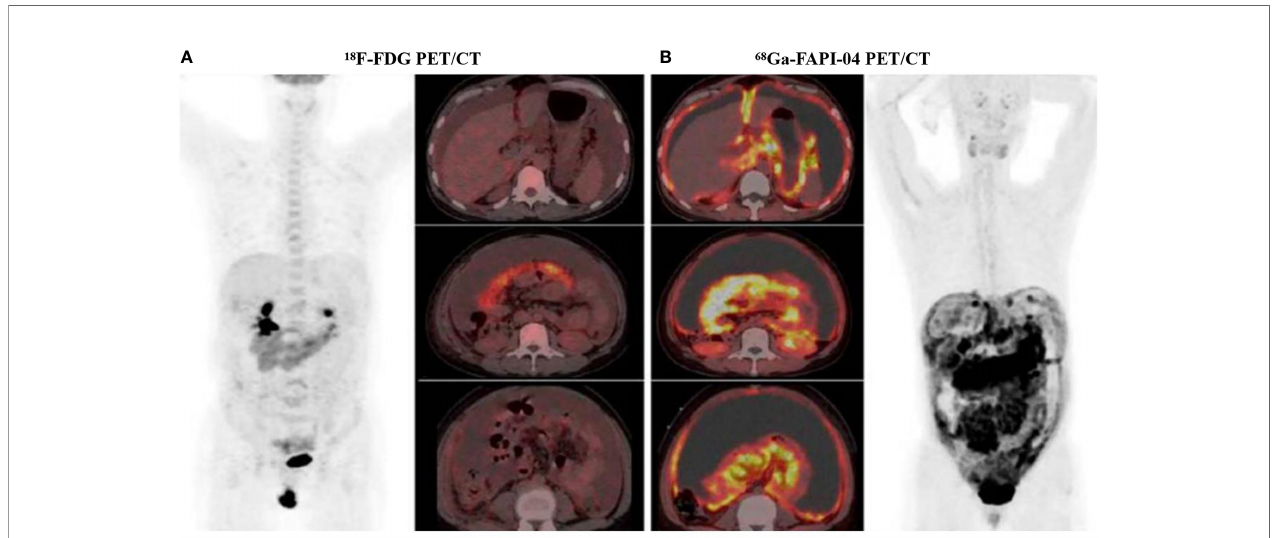
FIGURE 4 | A 47-year-old woman diagnosed with ovarian cancer, 18 F-FDG PET/CT showed the omental-cake-pattern of peritoneal carcinomatosis with low-to- moderate activity throughout the entire abdomen and pelvis (A) . However, there were more details in 68 Ga-FAPI-04 PET/CT images, we could fi nd that higher uptake was observed in the omental and peritoneal surfaces, especially around the liver and small bowel mesenterium (B) . Subsequent pathological fi ndings were consistent with 68 Ga-FAPI-04 PET/CT fi ndings. 68 Ga-FAPI-04 PET/CT showed superiority over 18 F-FDG PET/CT in the display of peritoneal metastatic carcinoma. With permission from Chen et al.